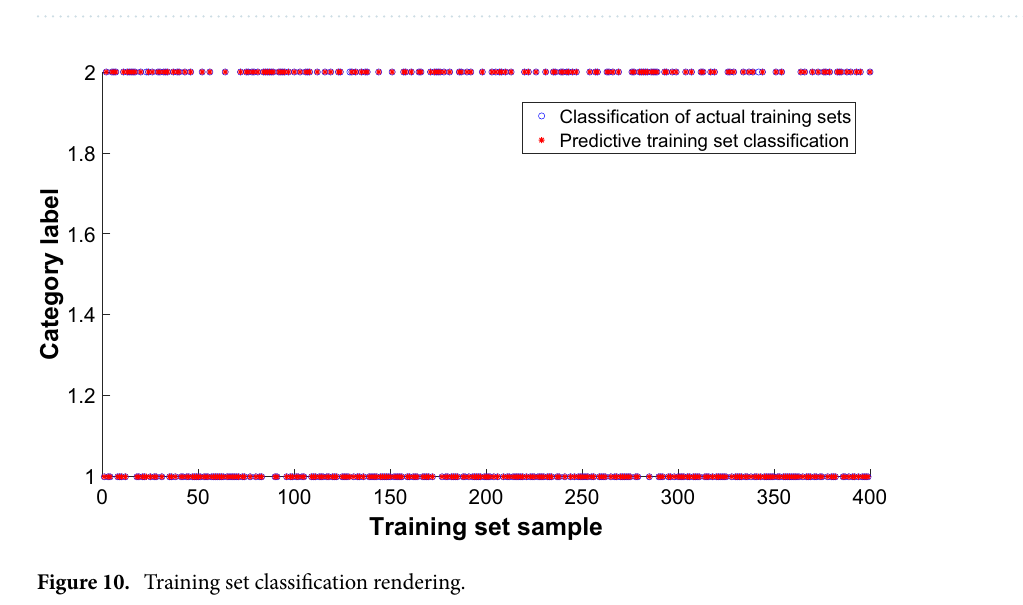
Figure 9. Comparison of accuracy and time of different SPREAD values.